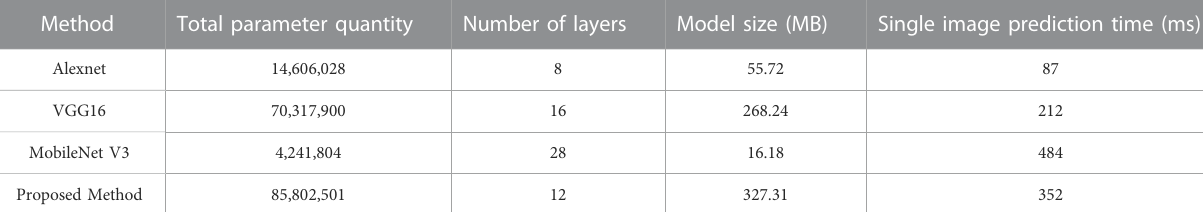
TABLE 4 Total parameter quantity and prediction time of different models.